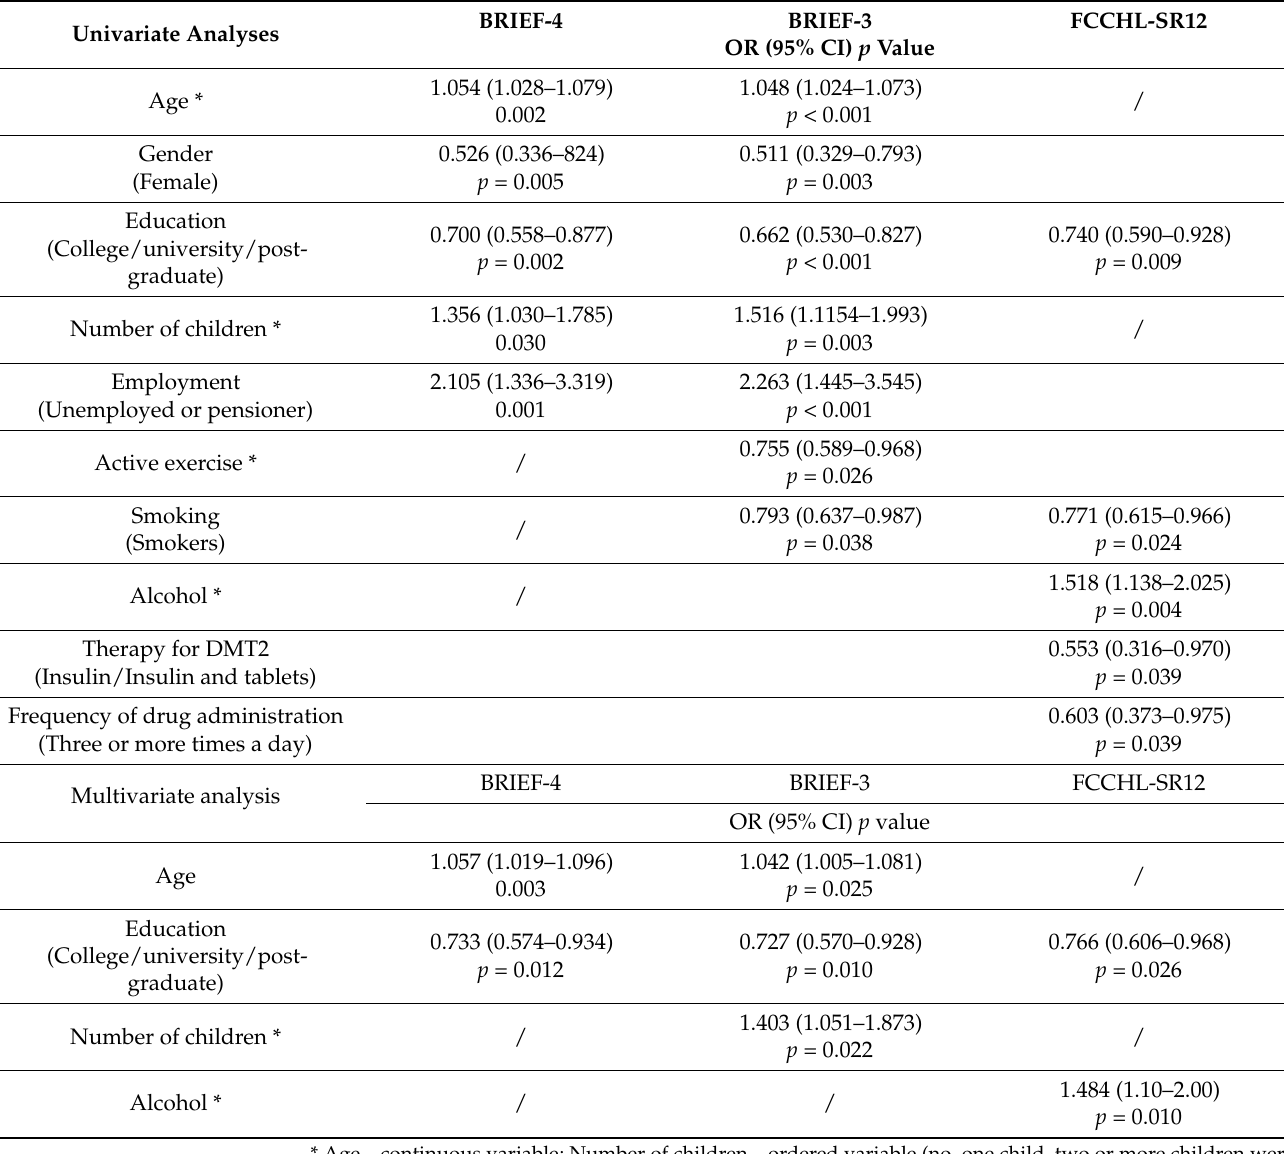
Table 4. Sociodemographic characteristics as predictors for